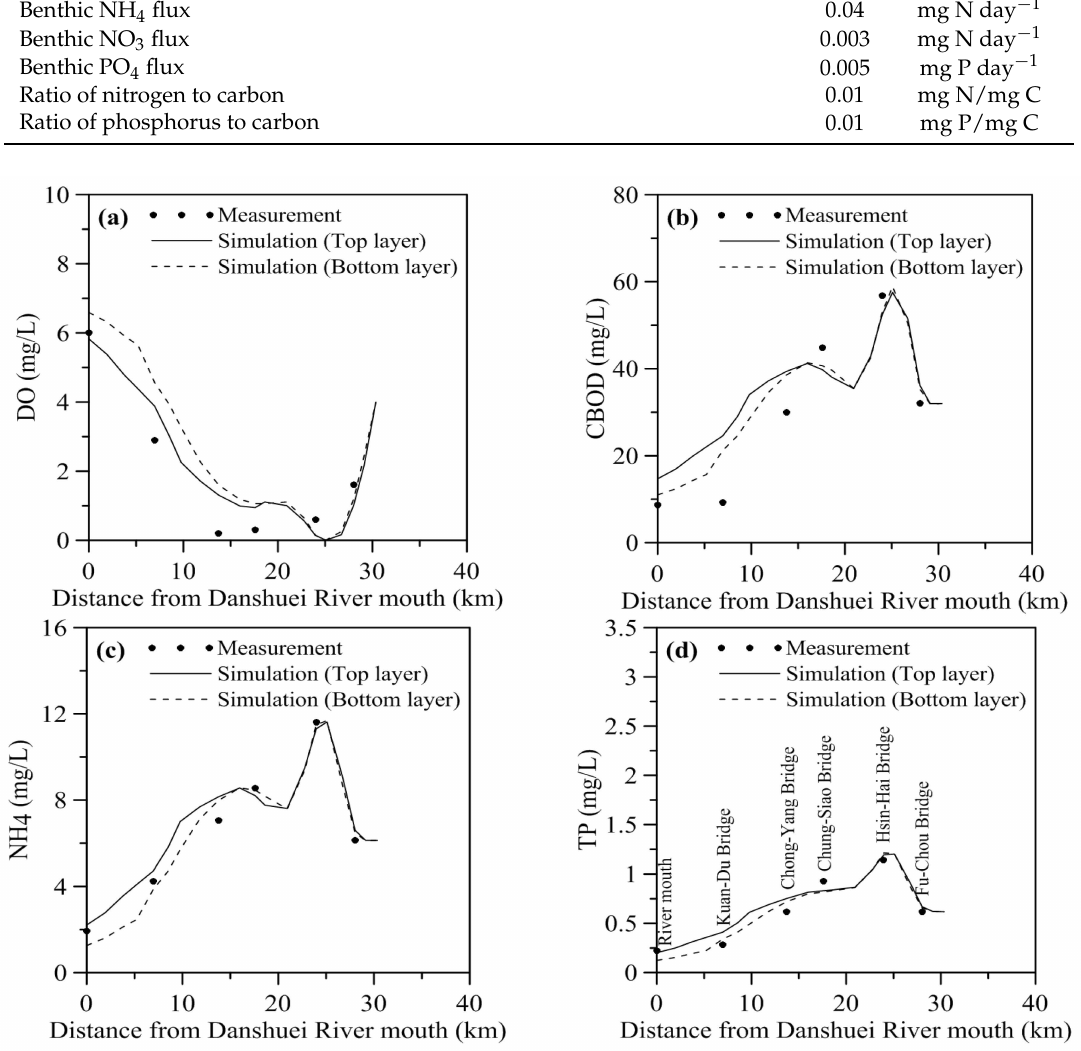
Figure 5. The comparison between the measured and simulated water quality distributions along the Danshuei River to the Tahan Stream on 3 March 2011 ( a ) DO; ( b ) CBOD; ( c ) NH 4 ; and ( d )